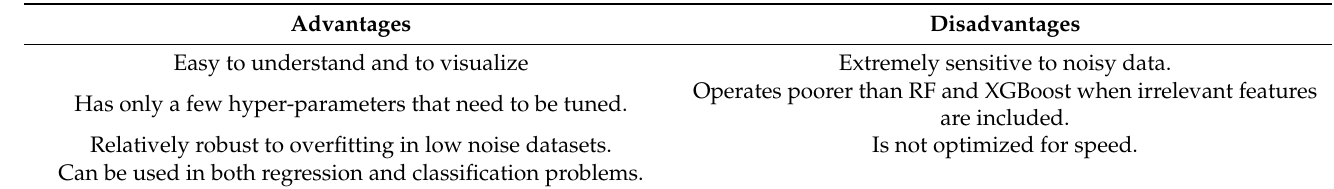
Table 3. Advantages and disadvantages of AdaBoost.